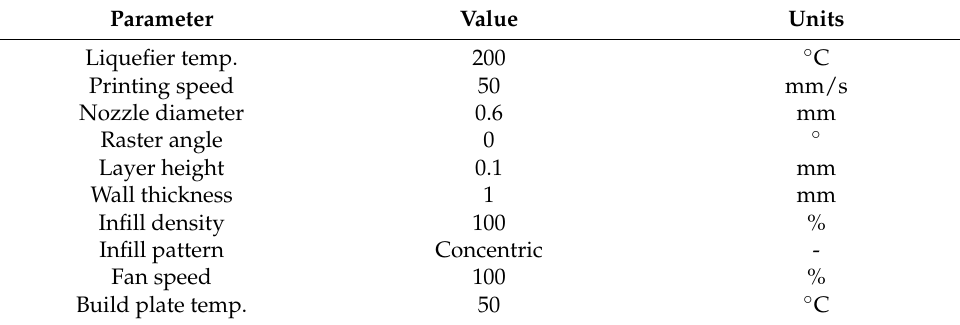
Table 1. Three-dimensional printing parameters used.